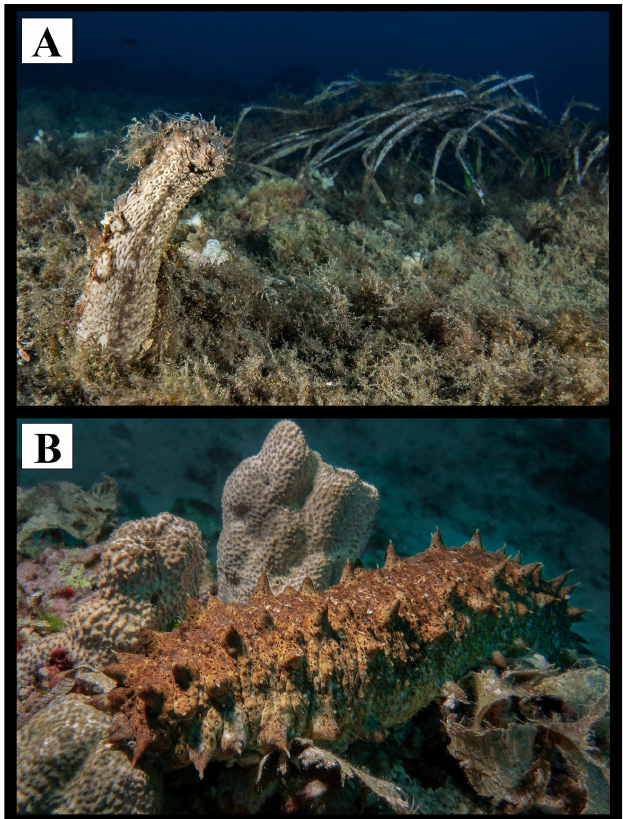
Figure 2. Underwater photographs of Holothuria tubulosa ( A ) An adult showing the typical reproductive and gamete release behavior. ( B ) Close-up of H. tubulosa individual. Pictures credits: Michele Solca.